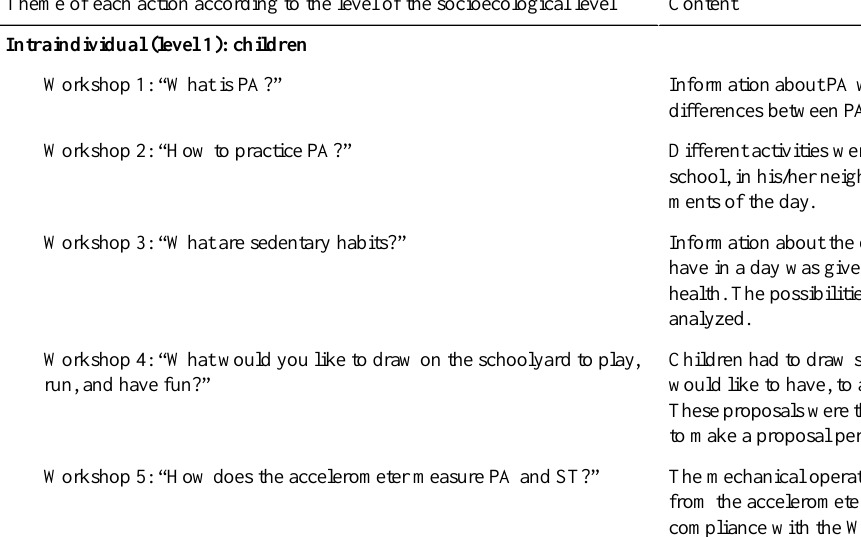
Table 2. The different axes of the intervention: content and objectives. ContentTheme of each action according to the level of the socioecological level Intraindividual (level 1):